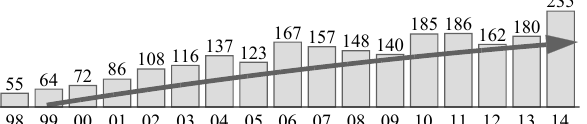
Figure 1: Number of recall campaigns of cars in Ger- many from 1998-2014, data from DAT